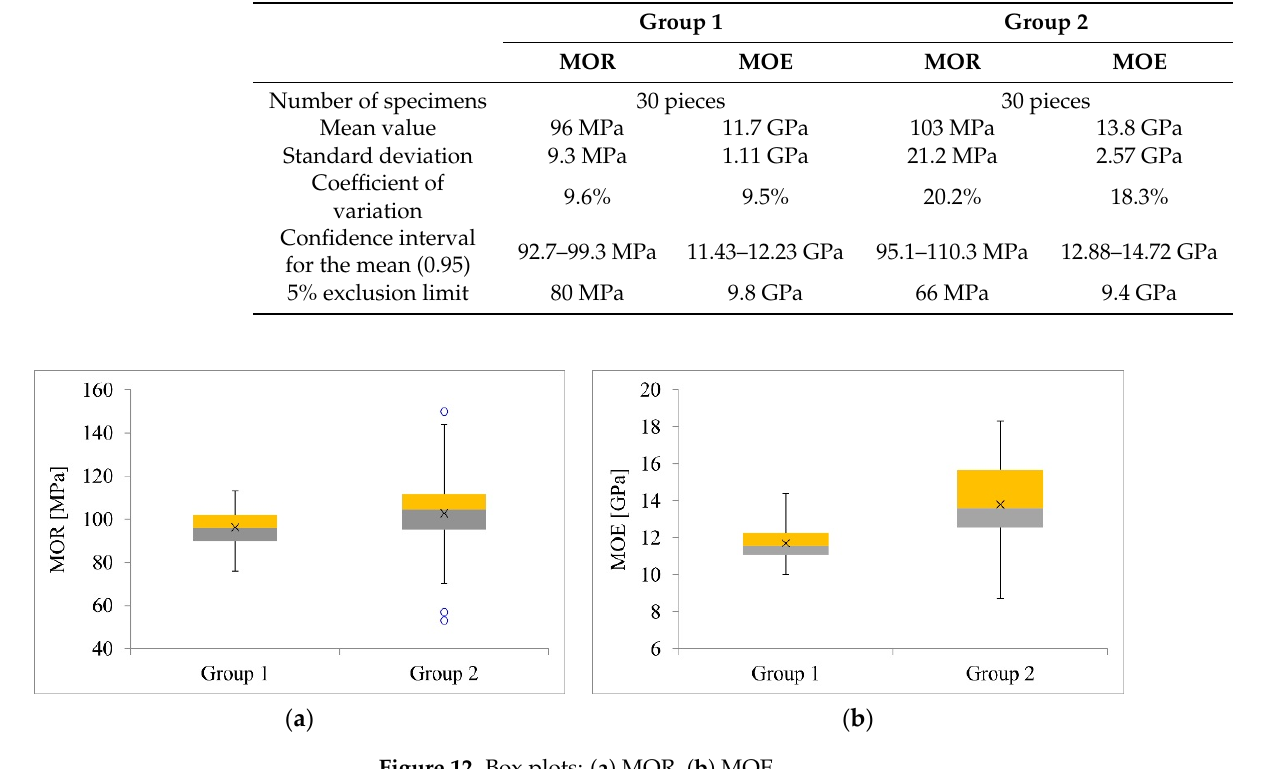
Table 15. Results of small clear specimen bending tests.